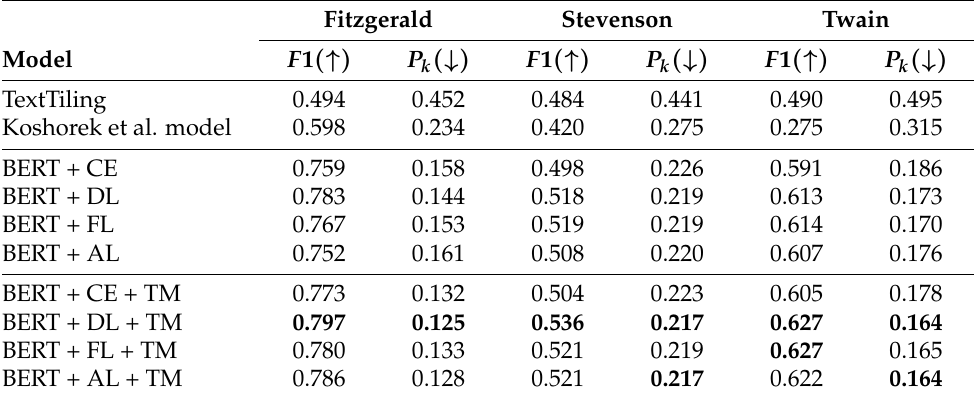
Table 4. Experiment results for each model. The higher F 1 is, the better the outcome. By contrast, the lower P k is, the better the results. Bold values represent the best evaluation results for each dataset. Fitzgerald Stevenson